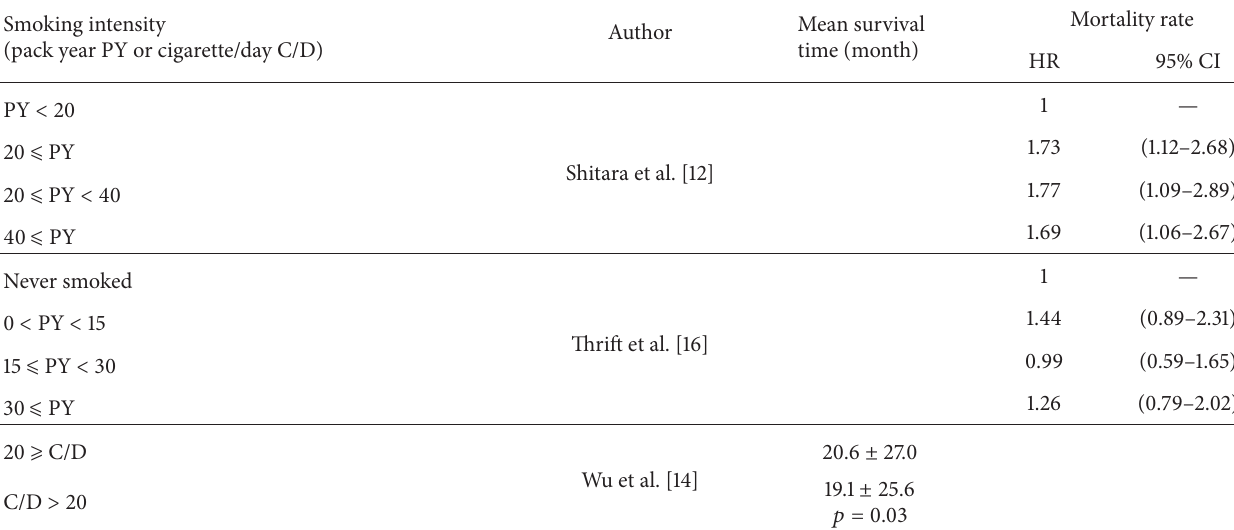
Table 4: Mortality and survival of EC patients for different